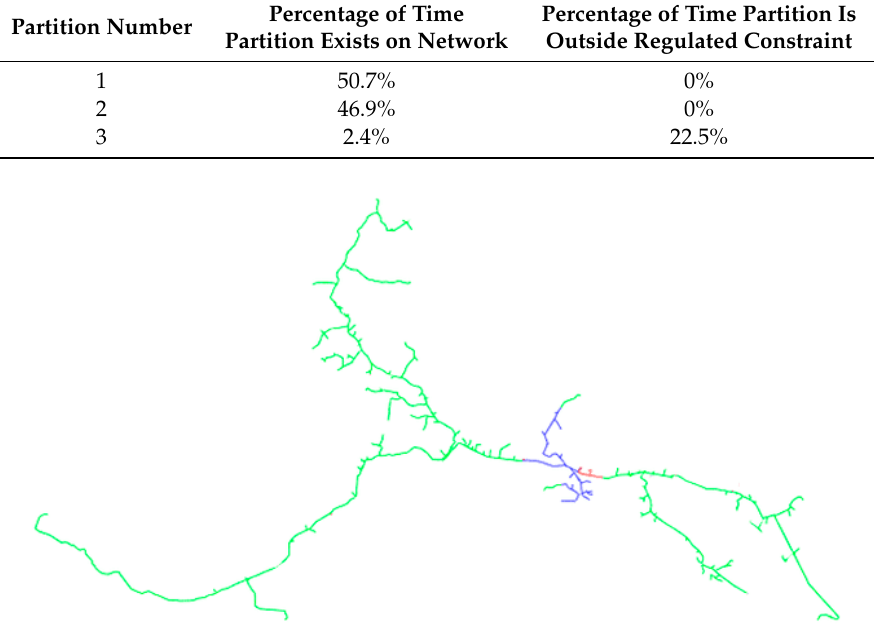
Figure 19. Real distribution feeder with regions of compliance (green), undervoltage (red) and overvoltage (blue) highlighted for the maximum loading case on the network with the optimal tap settings applied. Table 4. Results of Monte Carlo simulations for each partition in Case 3.